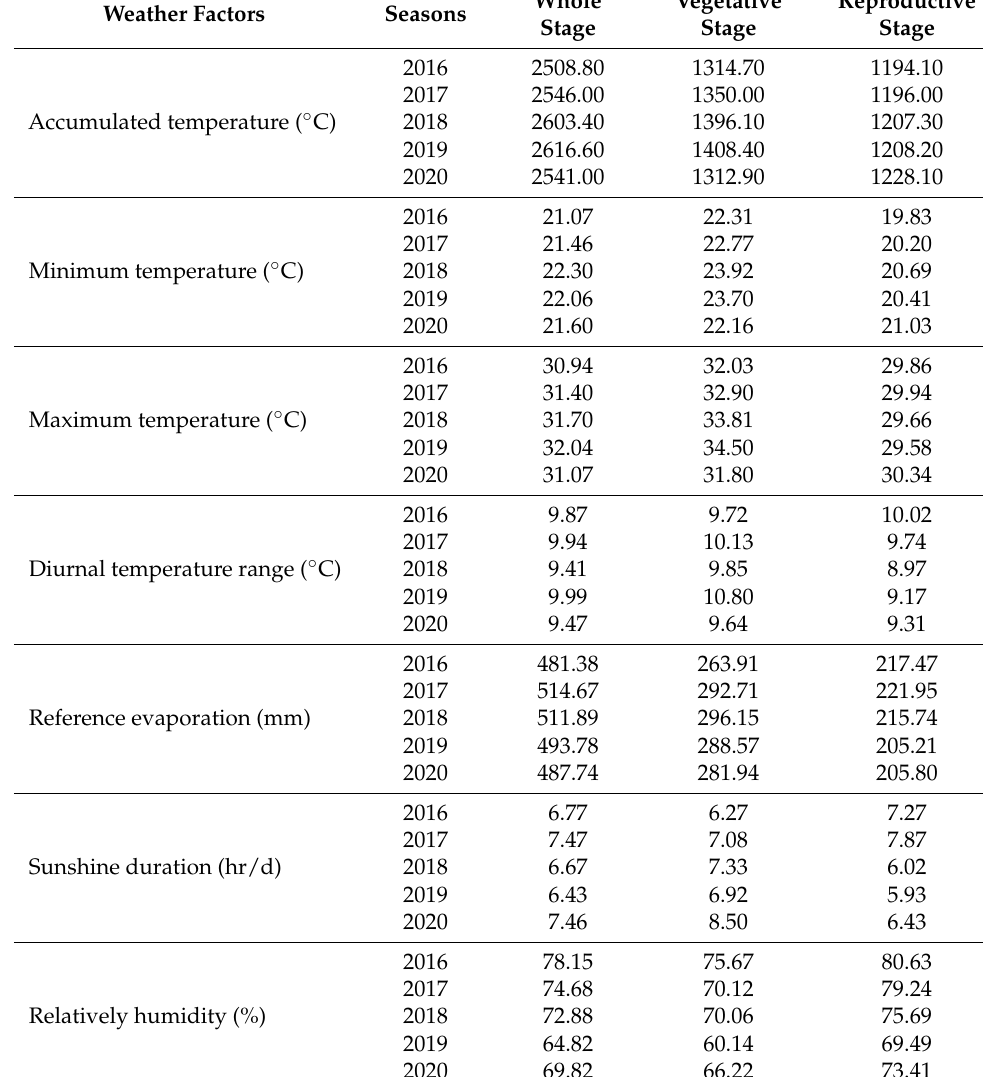
Table A3. The major weather factors during the five seasons at different growing stages of foxtail millet. Weather Factors